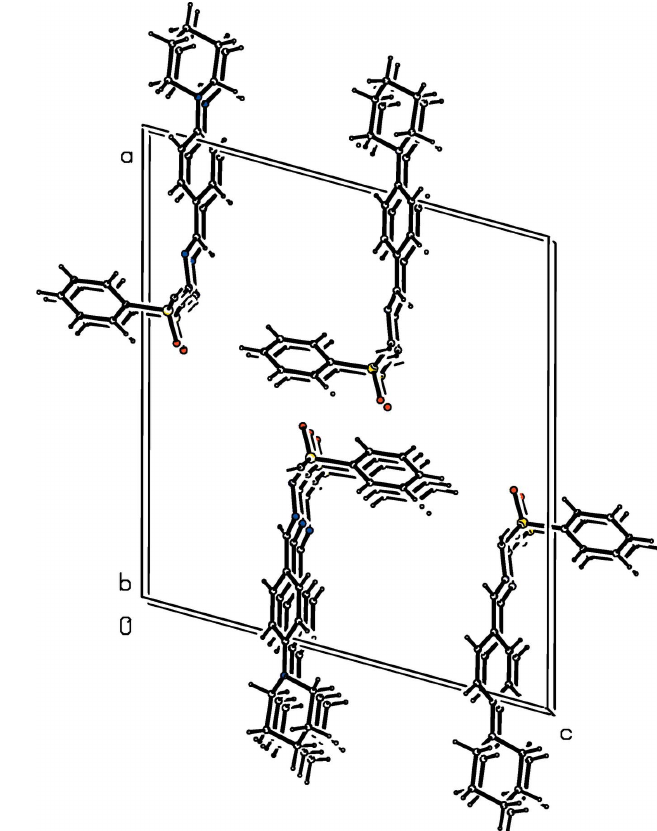
Figure 7 Molecular packing of